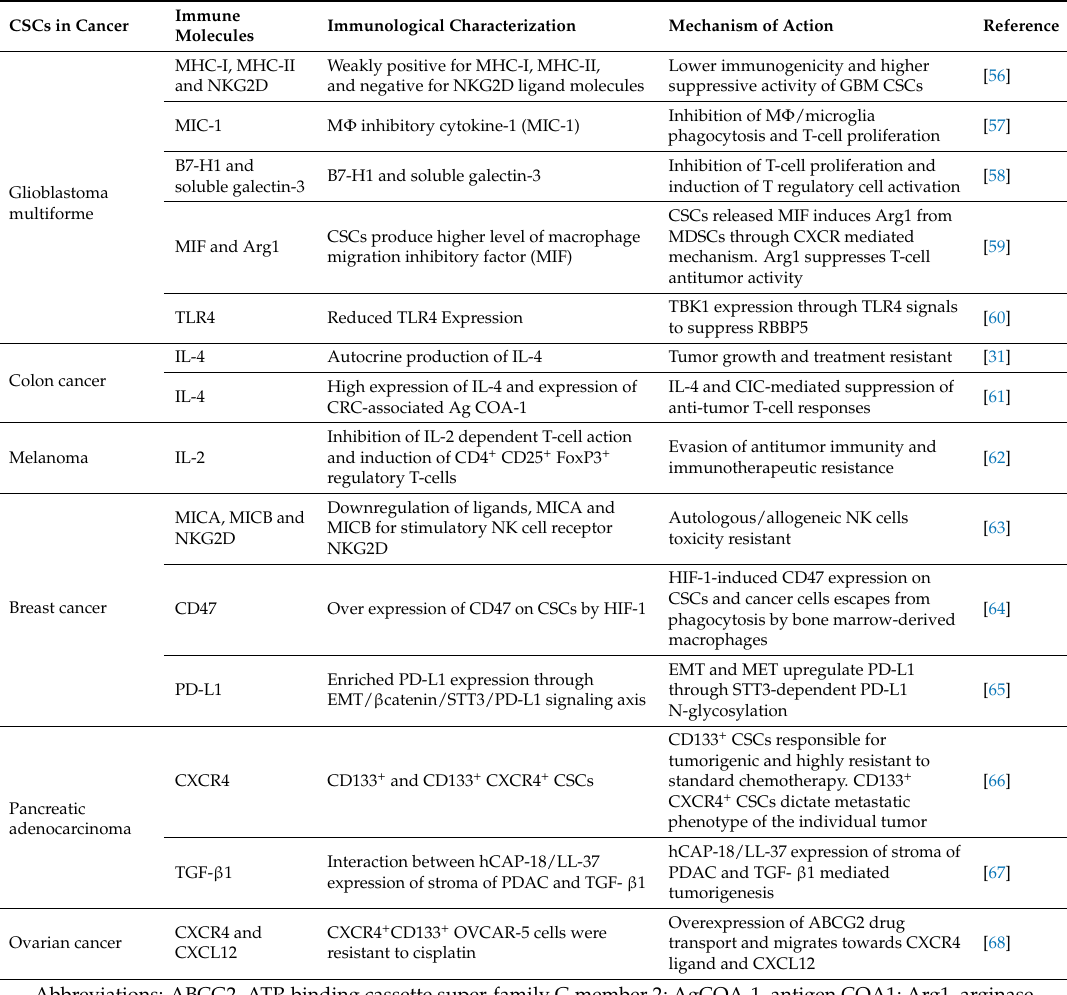
Table 2. Immune resistance of CSCs and their mechanism in various